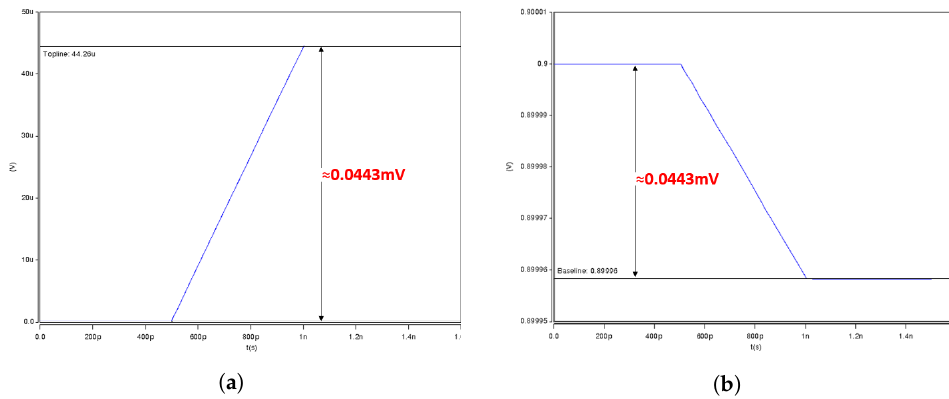
Figure 4. Charging or Discharging range with a single SRAM bit cell (0.0443 mV). ( a ) Charging range for +1 result. ( b ) Discharging range for − 1